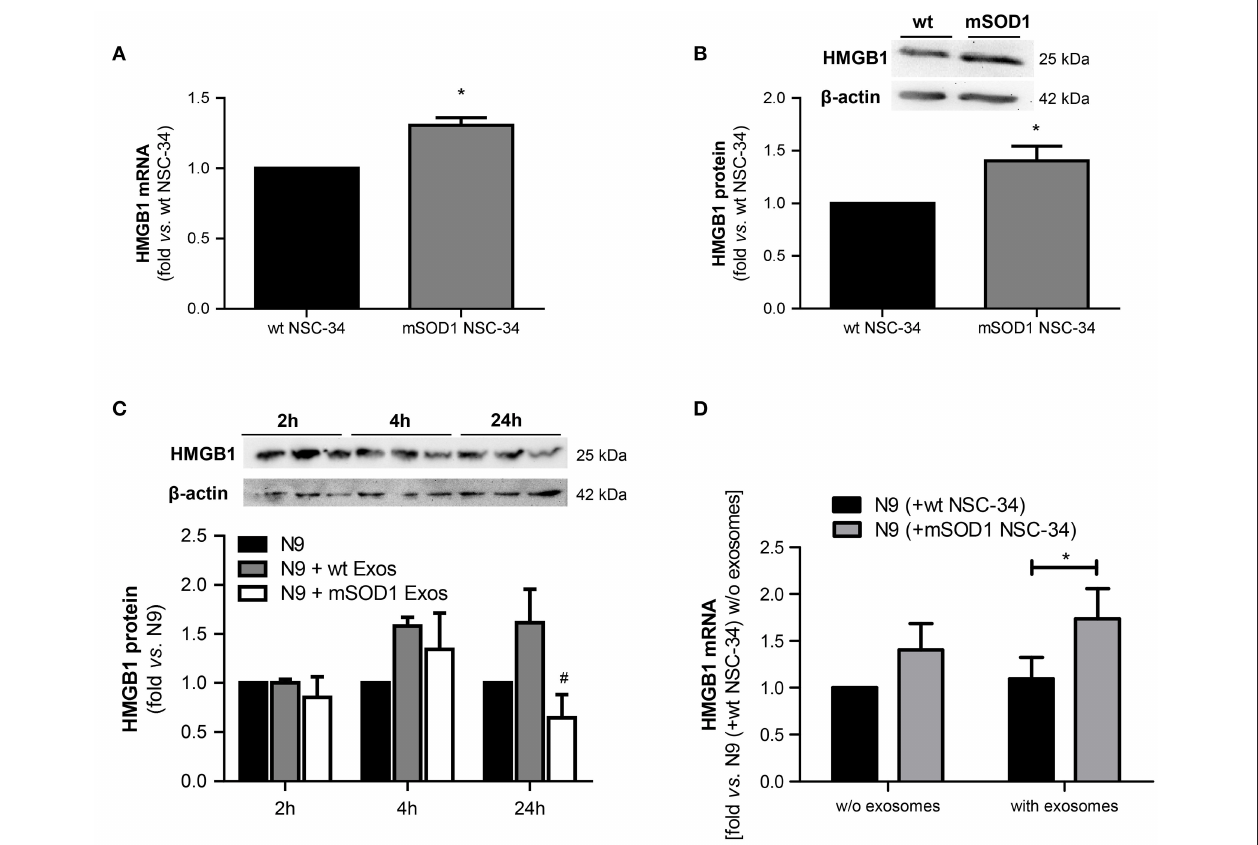
FIGURE 3 | HMGB1 upregulation is only observed in mSOD1 NSC-34 motor neurons (MNs) and in N9 microglia cocultured with MNs after surcharge with exosomes isolated from the coculture supernatants, mainly if containing mSOD1 MN-derived exosomes. High mobility group box 1 (HMGB1) gene (A) and protein (B) expression was evaluated by qRT-PCR and Western Blot, respectively, in NSC-34 cells expressing either human wild-type SOD1 (wt MNs), or mutated in G93A (mSOD1 MNs), after 4 days in vitro . HMGB1 protein was also evaluated in (C) N9 cells-microglia incubated for 2, 4, and 24 h with exosomes (Exos) from wild-type (wt) NSC-34 MNs and mSOD1 NSC-34 MNs (N9 + wt Exos and N9 + mSOD1 Exos, respectively) or in (D) N9 cocultured with either wt or mSOD1 MNs, incubated or not with exosomes isolated from the media of a matched NSC-34-N9 coculture experiment, as indicated in methods. Results are mean ( ± SEM) from at least four independent experiments and are expressed as fold change vs. respective wt MNs. Differences between mSOD1 NSC-34 MNs and wt NSC-34 MNs were obtained by two-tailed Student’s t -test with Welch’s correction (A,B) . Differences between the three different groups at each time point were obtained by one-way ANOVA followed by Bonferroni post-hoc correction (C,D) * p < 0.05 vs. respective wt NSC-34 MNs. # p < 0.05 vs. treatment with exosomes from wt NSC-34 MNs.